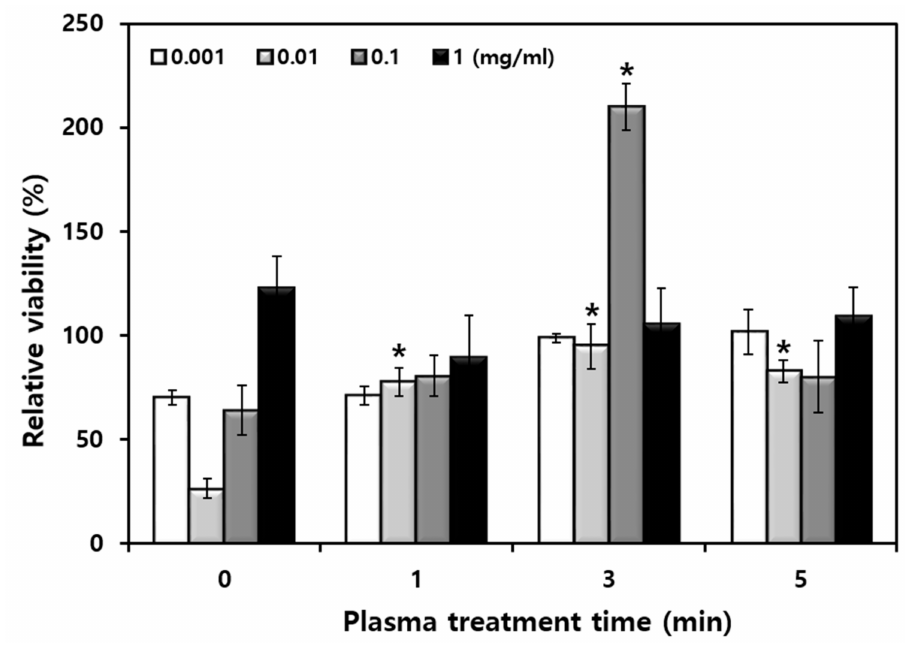
Figure 5. Cell viability of HFB according to the plasma treatment time. All measurements were made in 3 or more than 3 replicates. * p <